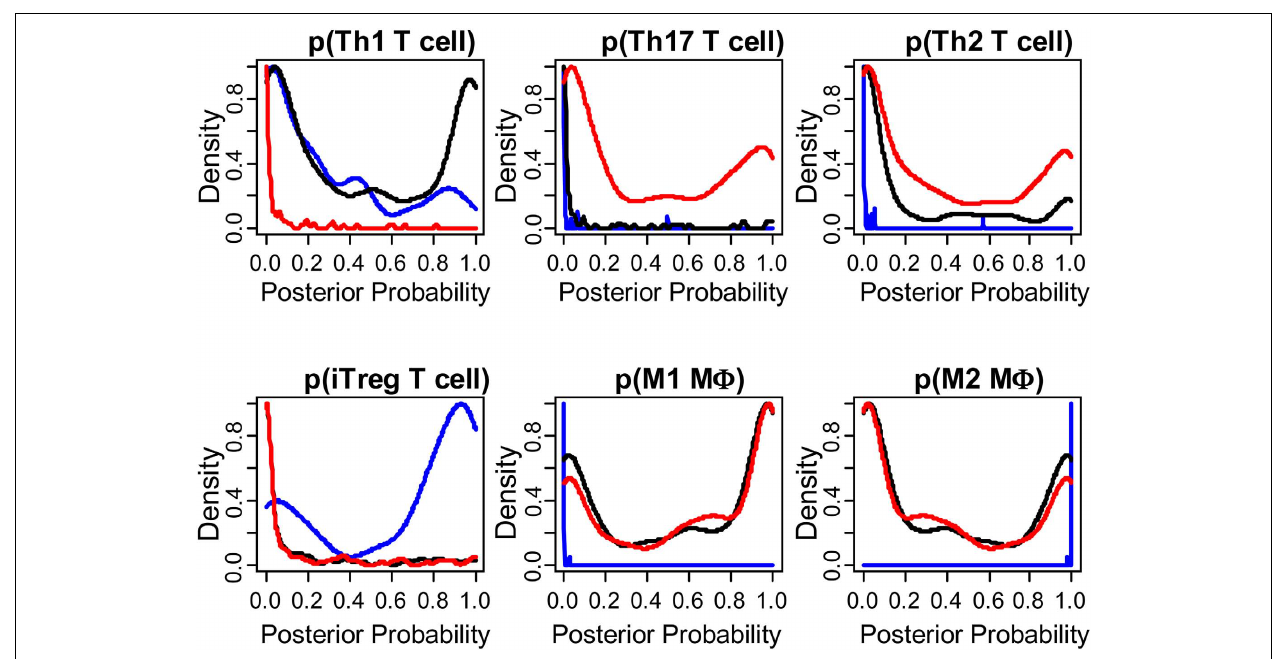
FIGURE 4 |The phenotype of immune cells within the tumor microenvironment are different among the three groups. Posterior probability distribution forT helper cell and macrophage phenotypes stratified by group, where probability was based on mutually exclusive gene expression patterns that are associated with each cell subset.T helper cell subsets were based upon gene clusters associated withTh1 ( CD4,TBX21, EOMES, FASL, IFNG, IL10 ),Th17 ( CD4, RORA, RORC, IL17A, IL17F ),Th2 ( CD4, GATA3,